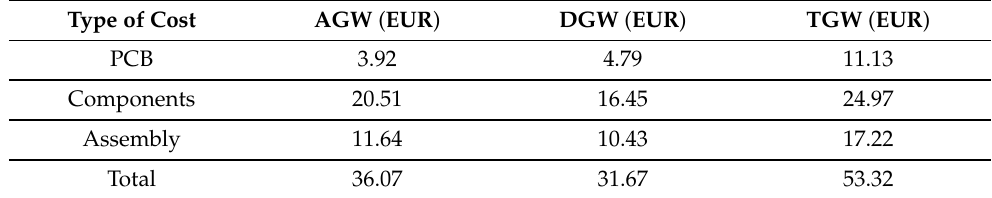
Table 2. Cost distribution for different types of cost and the three different gateways. The number of manufactured devices ordered amount to 57 pcs. for the AGW, 38 pcs. for the digital gateway (DGW), and 22 for the TGW. Prices from EUROCIRCUITS N. V., June 2020. Type of Cost AGW ( EUR ) DGW ( EUR ) TGW ( EUR )